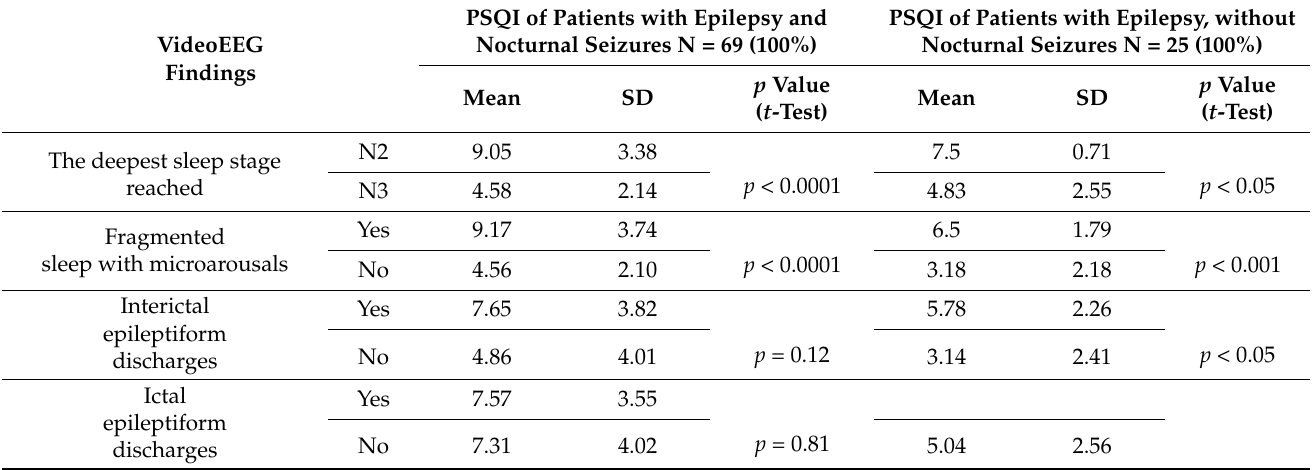
Table 6. PSQI depending on the distribution of sleep stages and epileptiform discharges on video-EEG.